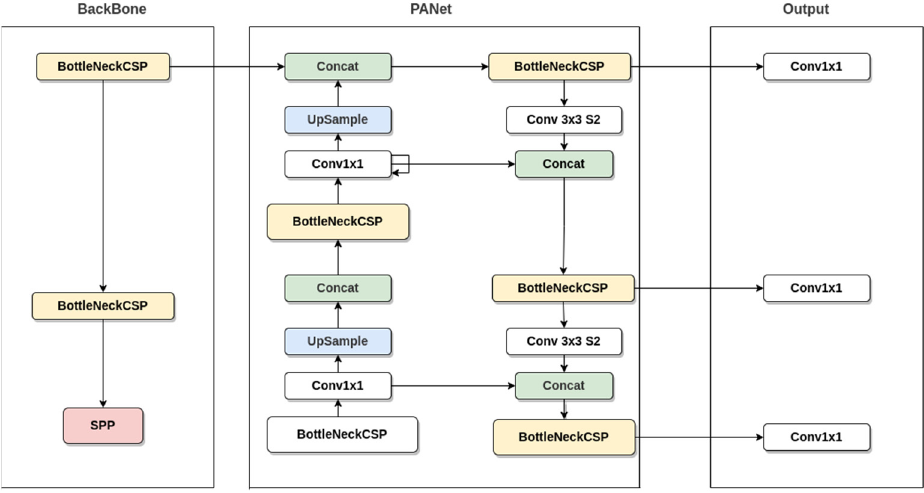
Figure 4. YOLOv5 architecture [29].